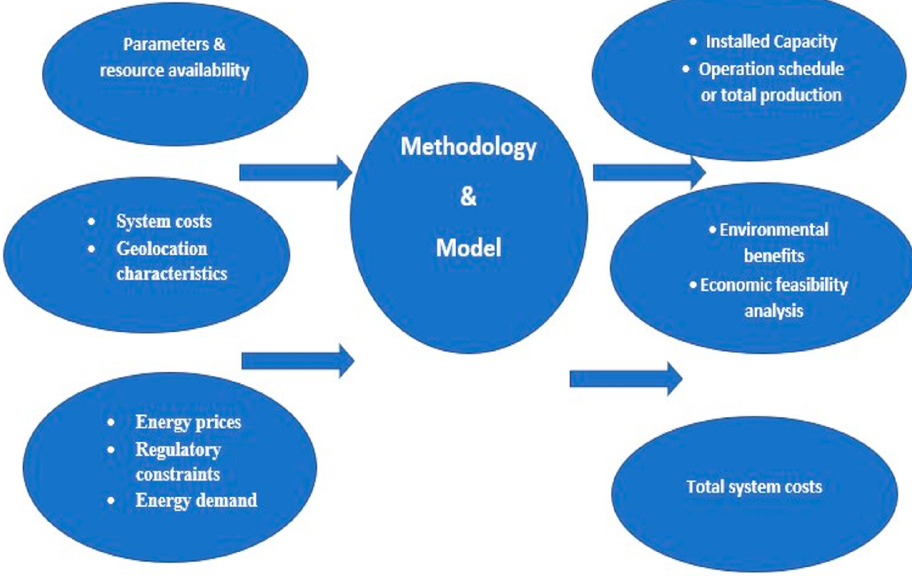
Figure 1. Energy system design model [13] .